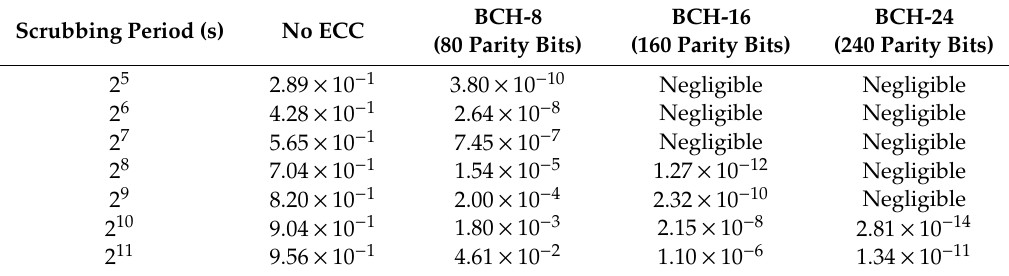
Table 2. LERs of 512-bit 4LC PCM with various scrubbing periods and